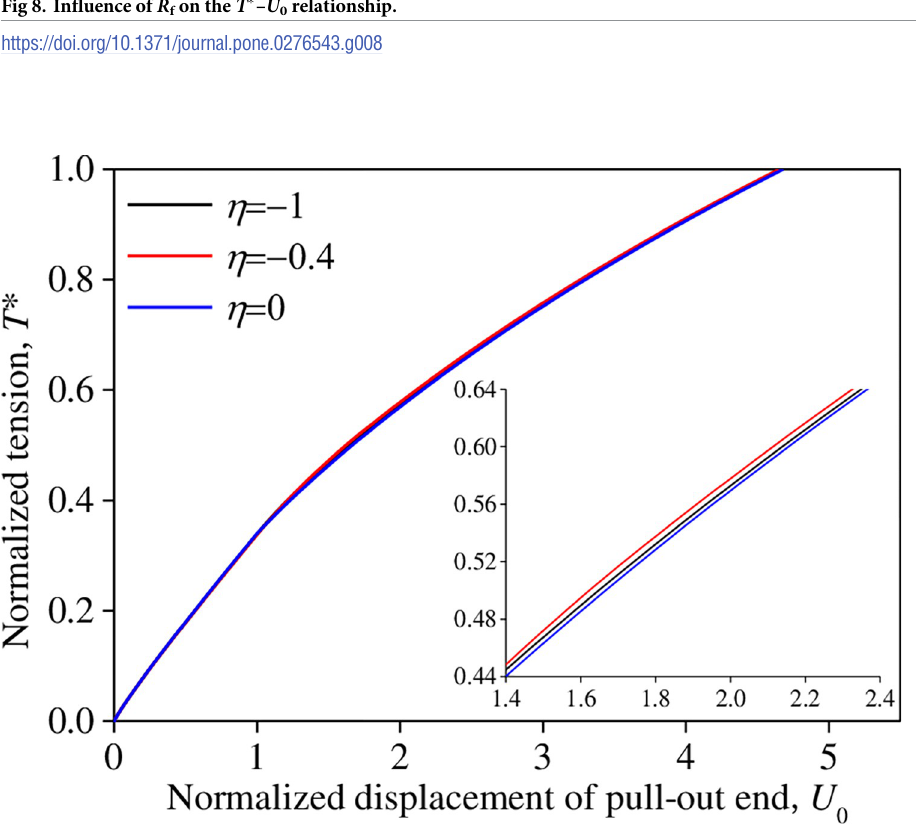
Fig 9. Influence of η on the T � – U 0 relationship.